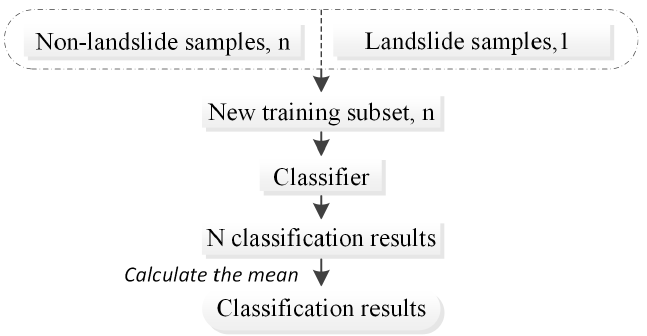
Figure 4. The EasyEnsemble technology approach can overcome the problem of unbalanced land- slide samples .